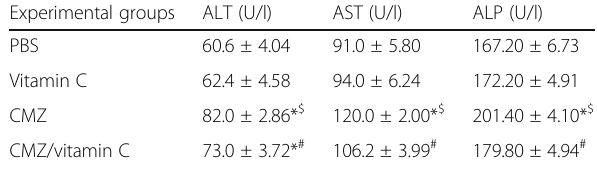
Table 4 Changes in the level of serum kidney biochemical markers; urea and creatinine of male Swiss albino mice treated